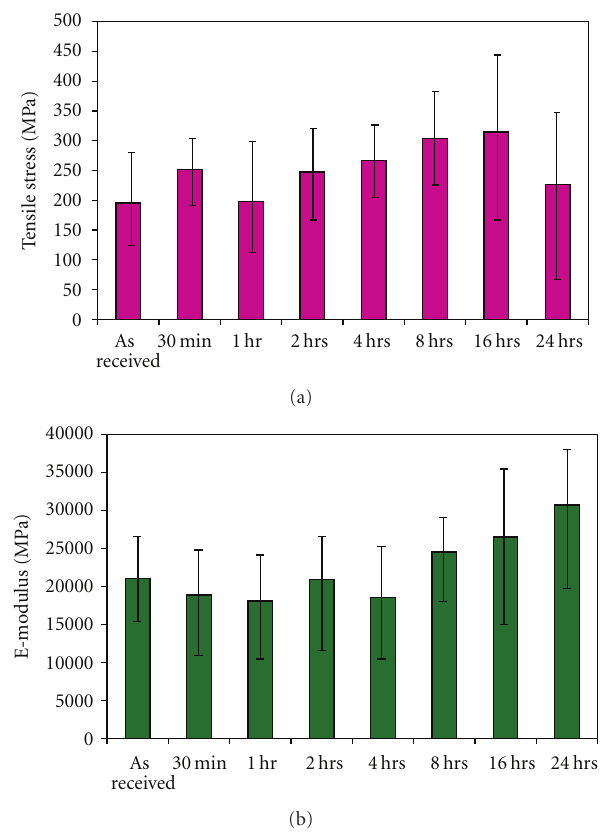
Figure 11: E ff ect of alkali treatment time on (a) tensile stress and (b) Young’s moduli in untreated and alkali-treated kenaf fibril bundles.